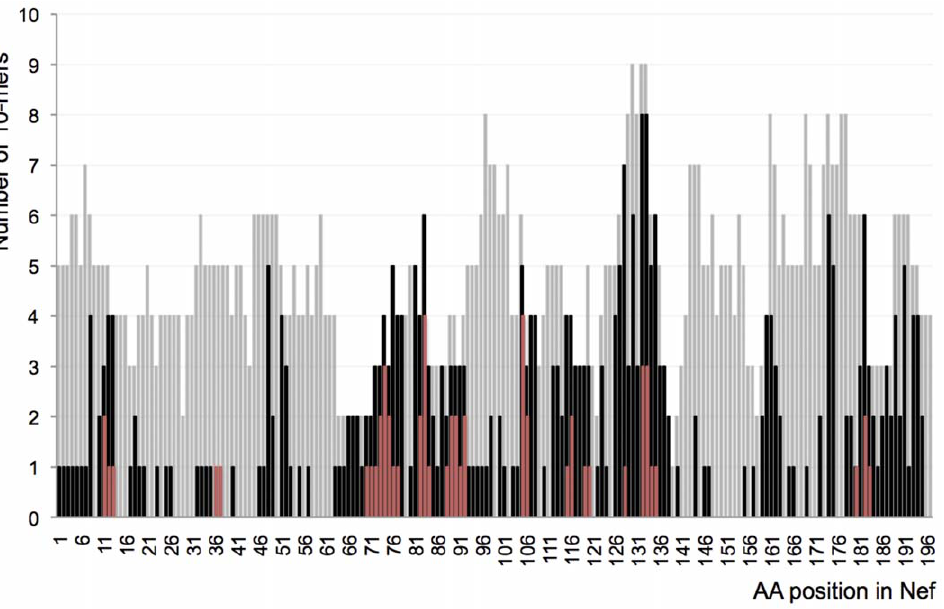
Figure 1. Distribution of reactive 10-mers and known epitopes in Nef. The number of 10-mers that were tested are represented as gray bars. Black bars correspond to the 10-mers that were recognized at least by one individual in our cohort. Red bars represent known epitopes that had previously been reported in the HIVDB. Each bar is placed at the start position of each 10-mer based on their HXB2 coordinates.